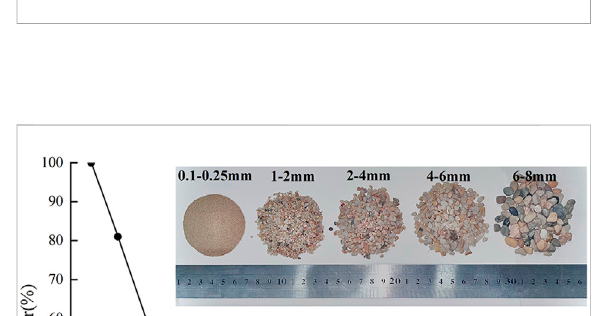
FIGURE 2 Schematic of calculation of fi ne-particle loss.